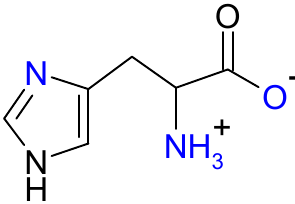
Figure 1. A potential tridentate ligand, L -histidine